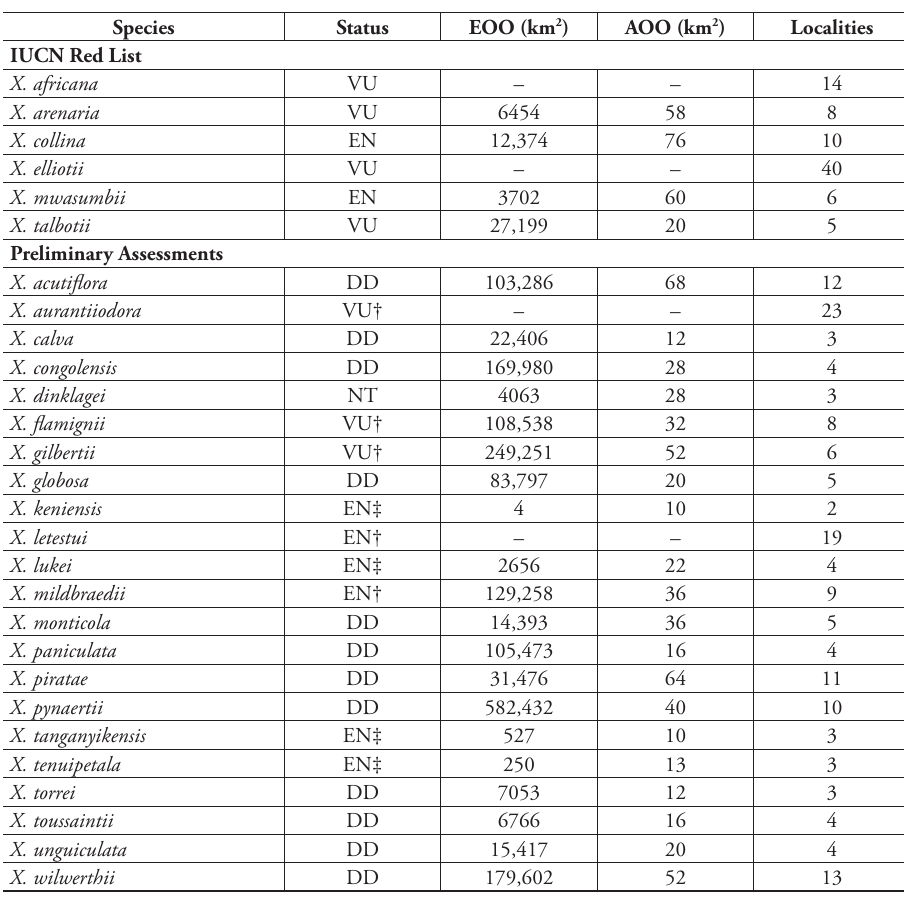
Table 1. Conservation assessment data for 28 African species of Xylopia . Threat status was taken from the IUCN Red List on 3 January 2018. Extent of Occurrence (EOO), Area of Occupancy (AOO), and number of localities based on the present study. IUCN status abbreviations are DD = Data Deficient, EN = Endangered, NT = Near Threatened, VU = Vulnerable. Footnoted references for published non-IUCN conservation assessments are † = Onana and Cheek 2011, ‡ = Johnson et al.